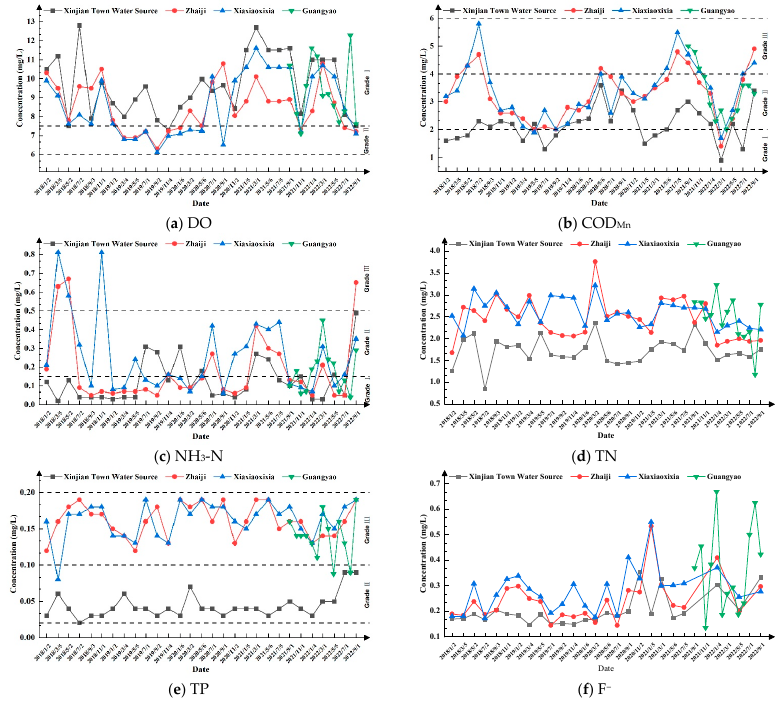
Figure 2. Variation of water quality concentration in the Xinjian River from January 2018 to September 2022. ( a – f ) represent DO, COD Mn , NH 3 -N, TN, TP and F − , respectively. The water quality type is labeled according to the surface water environmental quality standard of China (GB 3838-2002).